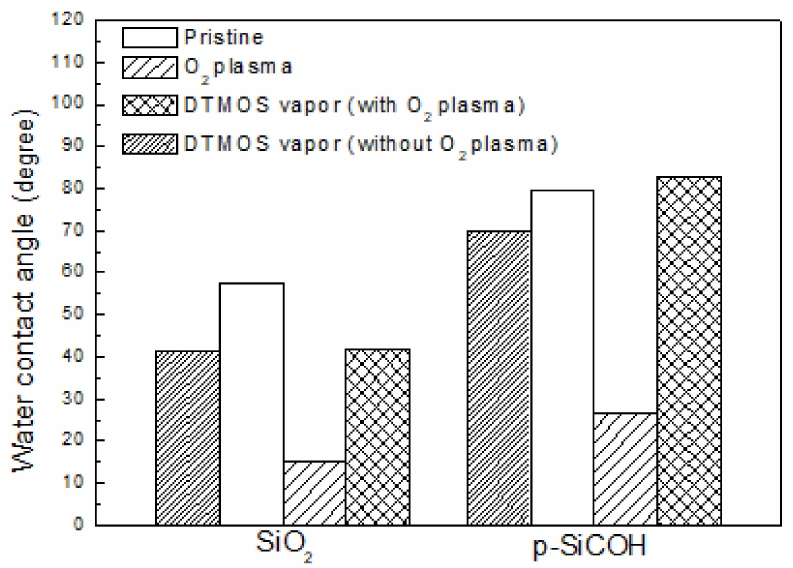
Figure 2. Water contact angle of SiO 2 and p-SiOCH films after O 2 plasma and DTMOS vapor